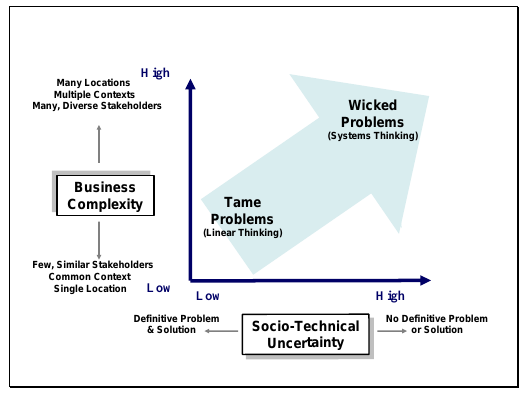
Figure 2: The Nature of Organizational